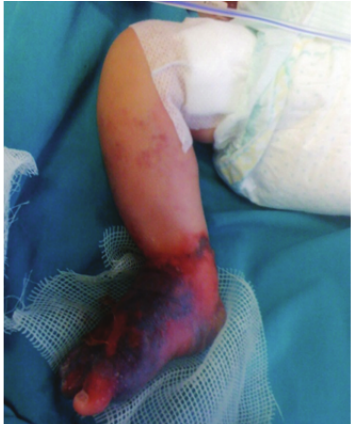
Figure 1: Foot ischemia before vascular surgery.